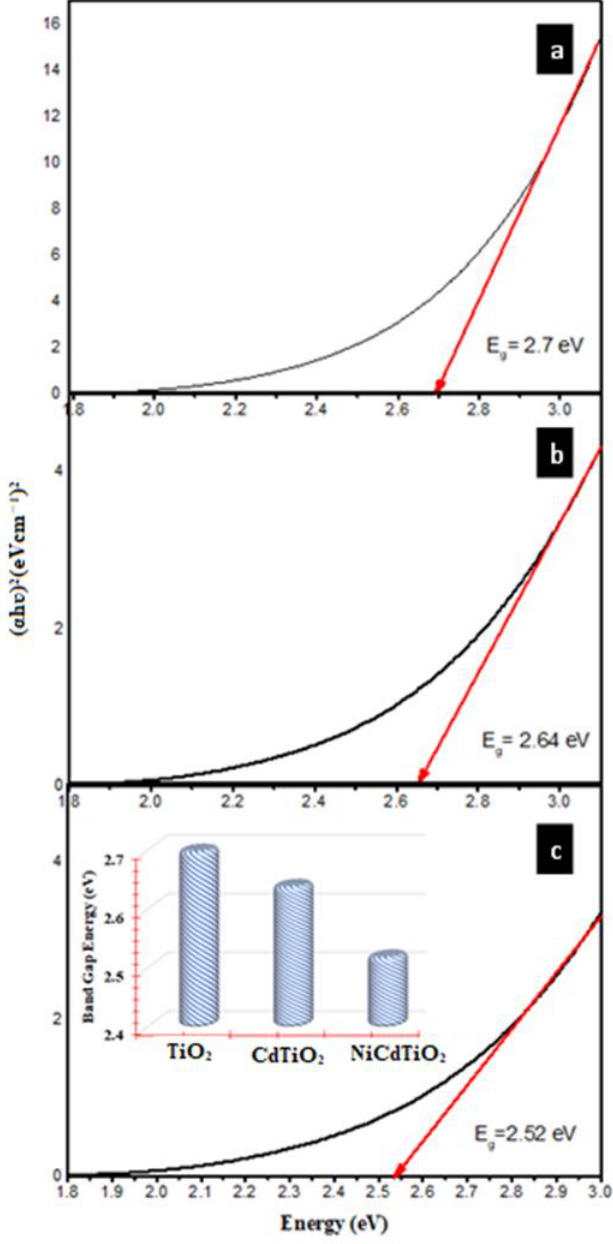
Figure 9. Tauc plots: ( α hv) 2 versus energy for the ( a ) TiO 2 ( b ) CdTiO 2 ( c ) NiCdTiO 2 , inset; comparison of band gap